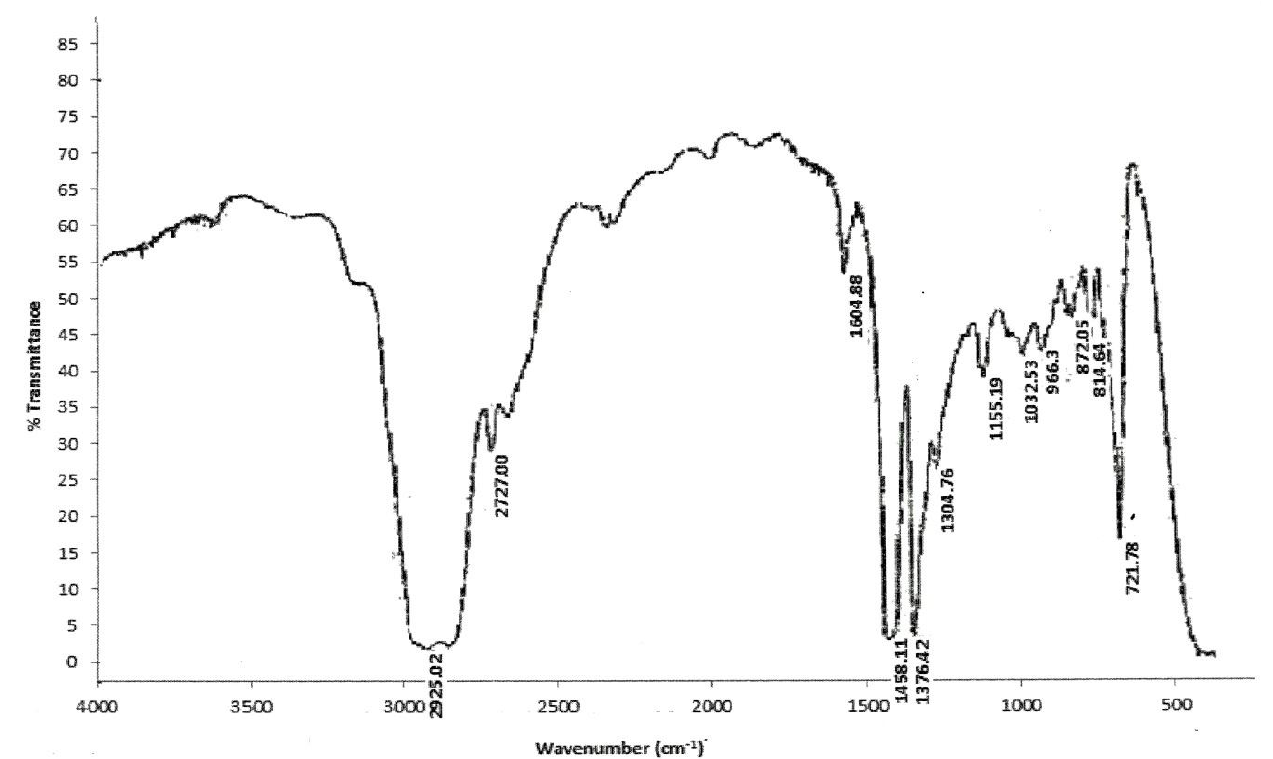
Figure 7. Results of analysis of the recycled oil (base oil only before adding the additives) by acetic acid-vacuum distillation-clay method.